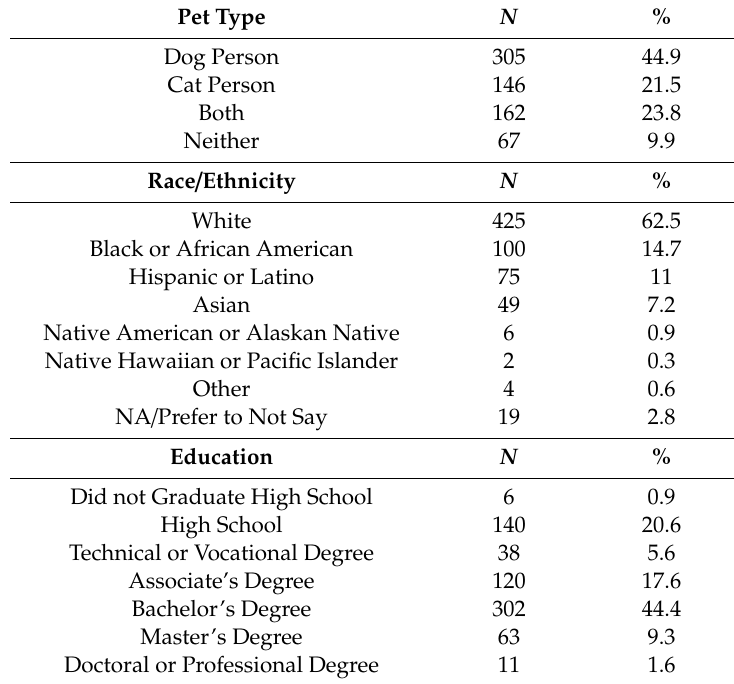
Table 4. Demographics of participants: Survey / Male 2.